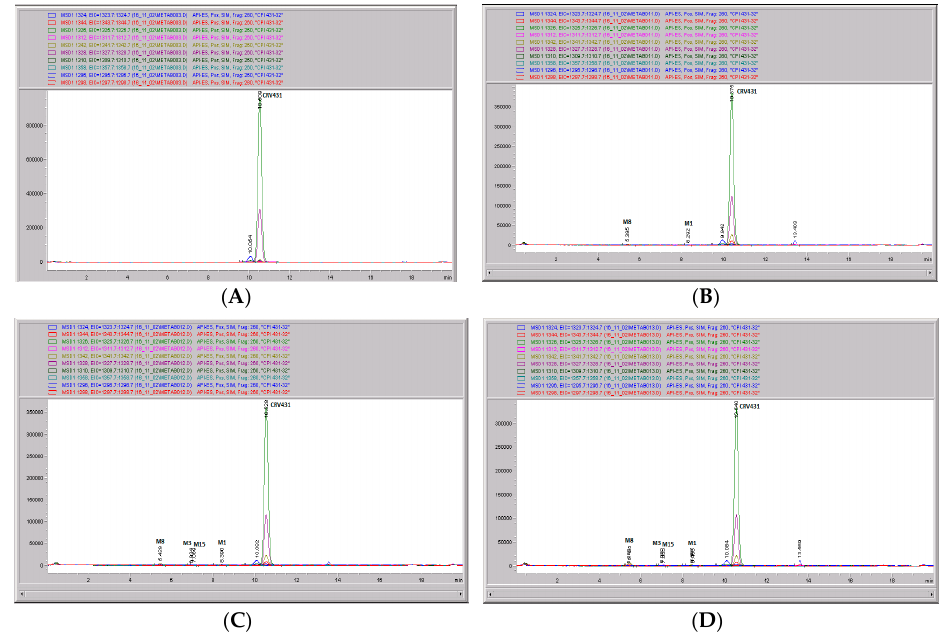
Figure 10. Mass spectral scans of rat liver extracts incubated with CRV431. Rat (Sprague-Dawley) liver microsomes (1 mg/mL) were incubated with 1 μ g/mL CRV431, and extracts were removed for analysis by ESI-LCMS at 20 min (panel ( A ), mass spectral scan from 1260–1460 m/z ) and 80 min (panel ( B ), mass spectral scan from 1260–1460 m/z ).